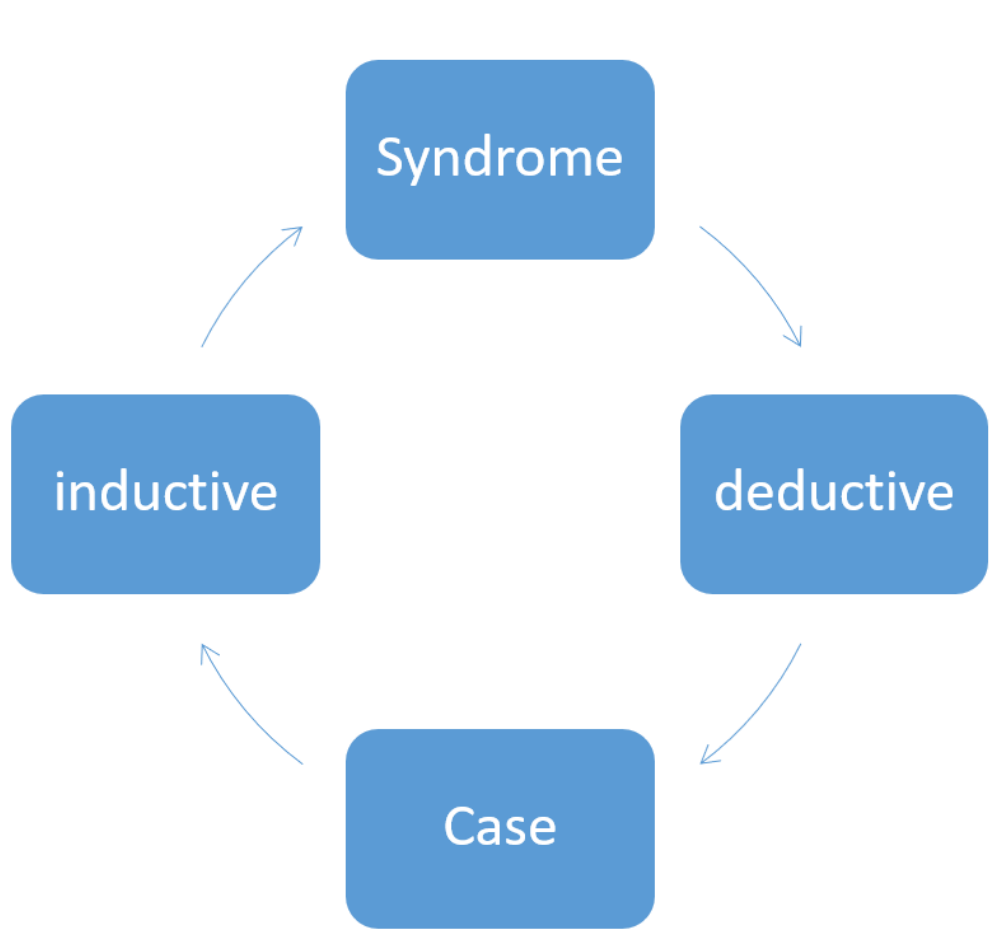
Figure 1. Deduction and induction in relation to syndromes (theory) and individual cases.